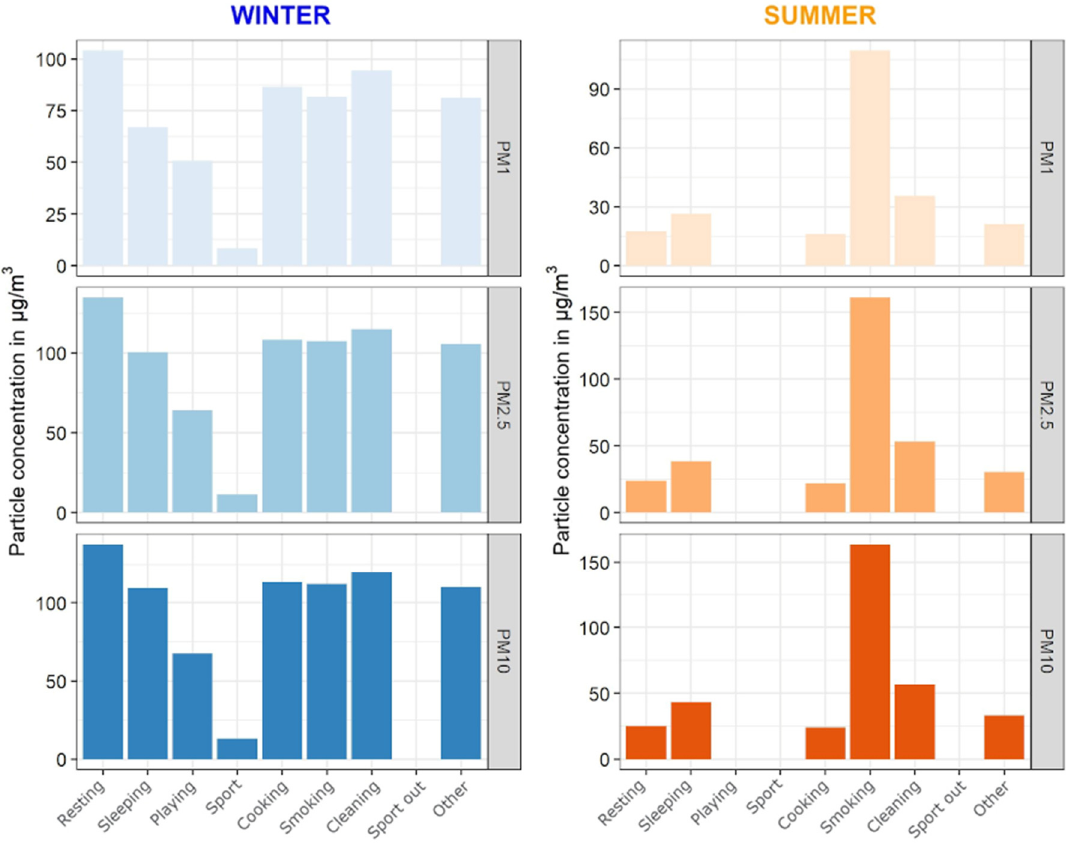
Figure 8. Faceted plots of average values of three size classes of PM (PM 1 , PM 2.5 , and PM 10 ) for each specific activity and each season; data from PPM and TAD.